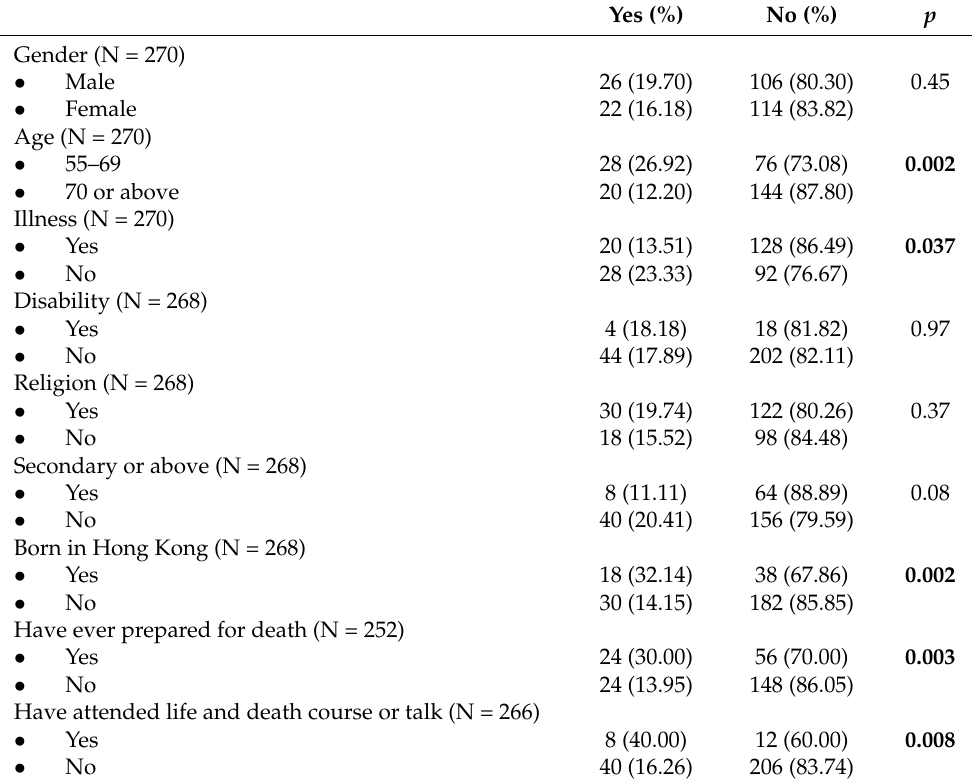
Table 2. Background characteristics of participants by advance care planning.